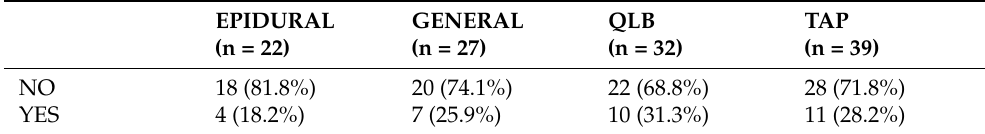
Table 3. Number and percentage of dogs in each of the four groups requiring intraoperative interven- tions to control nociception. No statistical differences were found among the groups; EPIDURAL vs. GENERAL ( p = 0.73), EPIDURAL vs. QLB ( p = 0.35), EPIDURAL vs. TAP ( p = 0.54), General